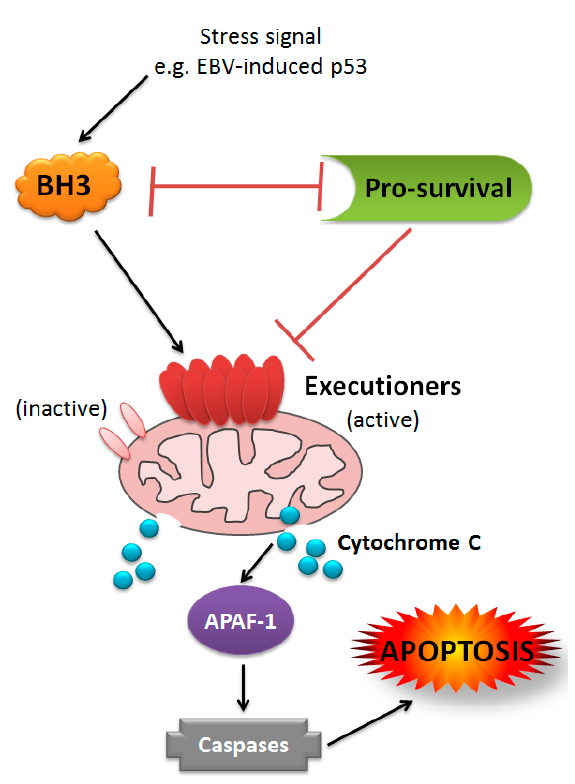
Figure 4. Model of BCL-2 family-mediated intrinsic apoptosis. Schematic of interactions among different classes of BCL-2 family members in the intrinsic apoptosis pathway. Pro-survival, BCL-2-like proteins, including BHRF1 (green), inhibit both classes of pro-death proteins, though the affinities and specificities for these binding partners vary. BH3-only, pro-death proteins (orange) inhibit pro-survival BCL-2s through reciprocal binding and some can directly activate executioner pro-death BCL-2 homologues (only BIM, PUMA and t-BID are able to perform direct activation). The executioner BCL-2s, BAK and BAX exist as inactive monomers until activated by BH3-only proteins or disinhibited by pro-survival BCL-2s. Upon activation, BAK and/or BAX multimerise to form pores in the mitochondrial outer membrane, causing the release of cytochrome C (and other pro-apoptotic factors), which then activate APAF-1, leading to the assembly of the apoptosome, caspase cleavage and consequent cell destruction.